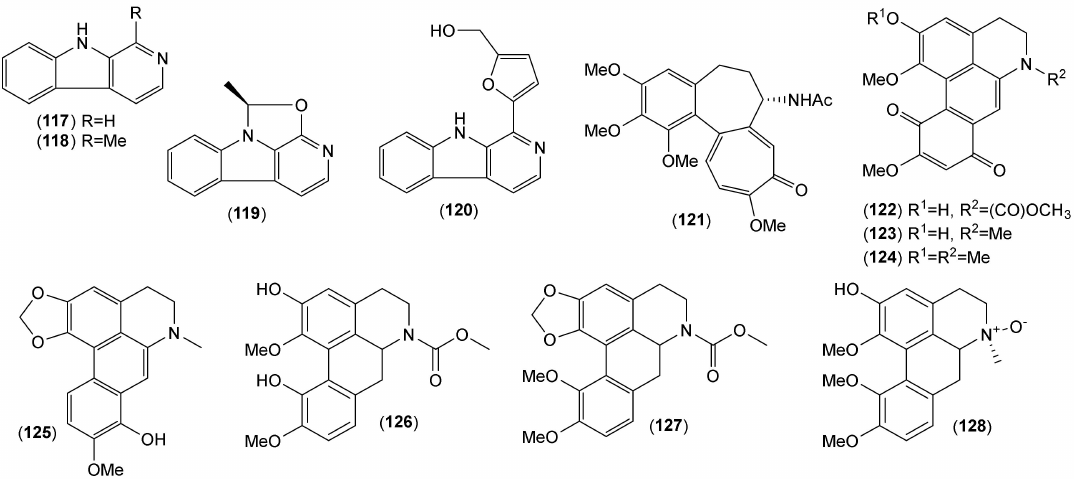
Figure 5. Alkaloids of other structural types isolated from Lycoris